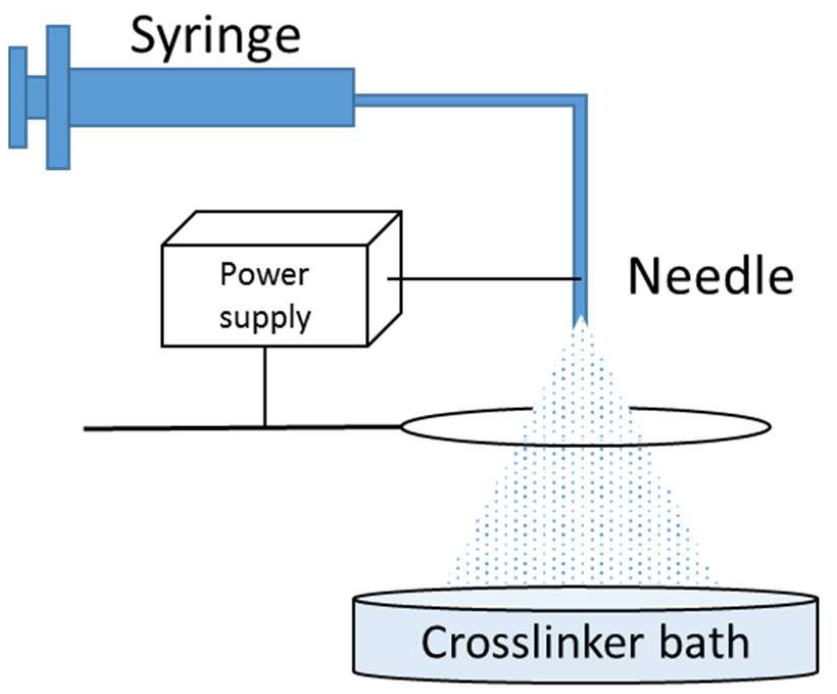
Figure 1. Electrospray set-up.